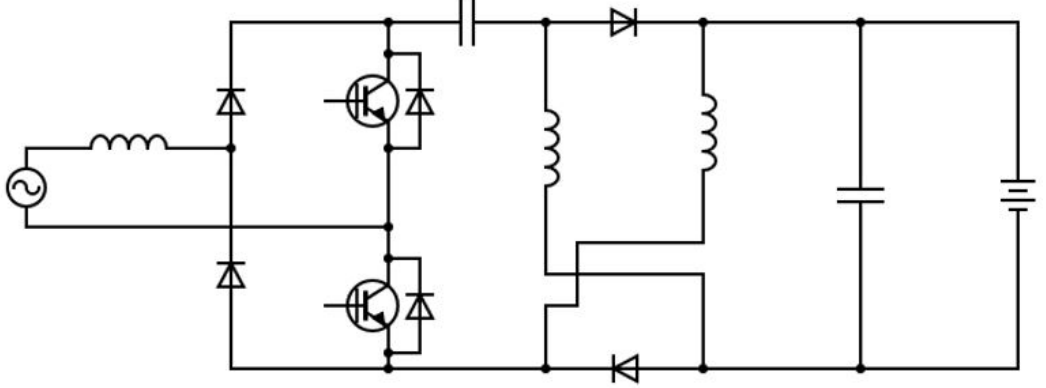
Figure 13. Bridgeless switched inductor SEPIC converter-based topology [53].